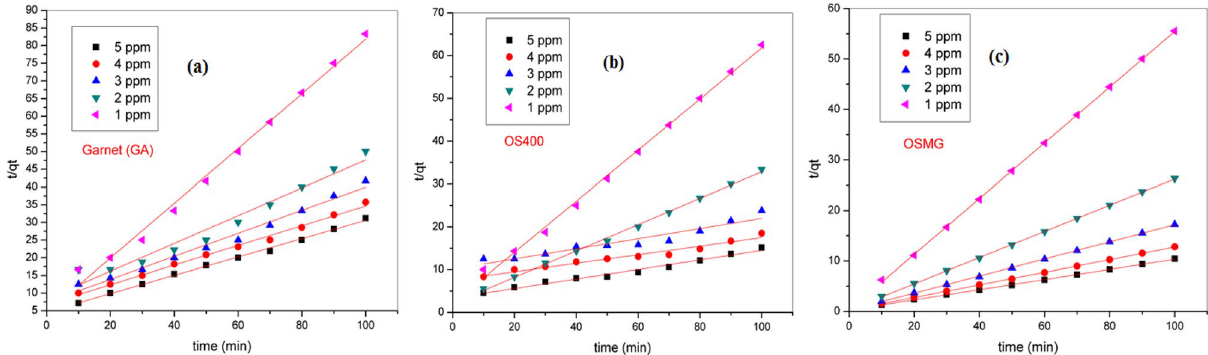
Figure 12. Pseudo-second-order kinetics for adsorption of MB dye onto ( a ) GA, ( b ) OS400 and ( c )